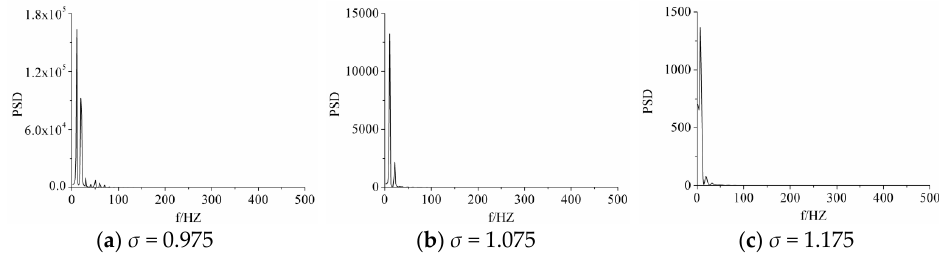
Figure 12. Acoustic power spectral density at U7 for σ = 0.975, 1.075, and 1.175.